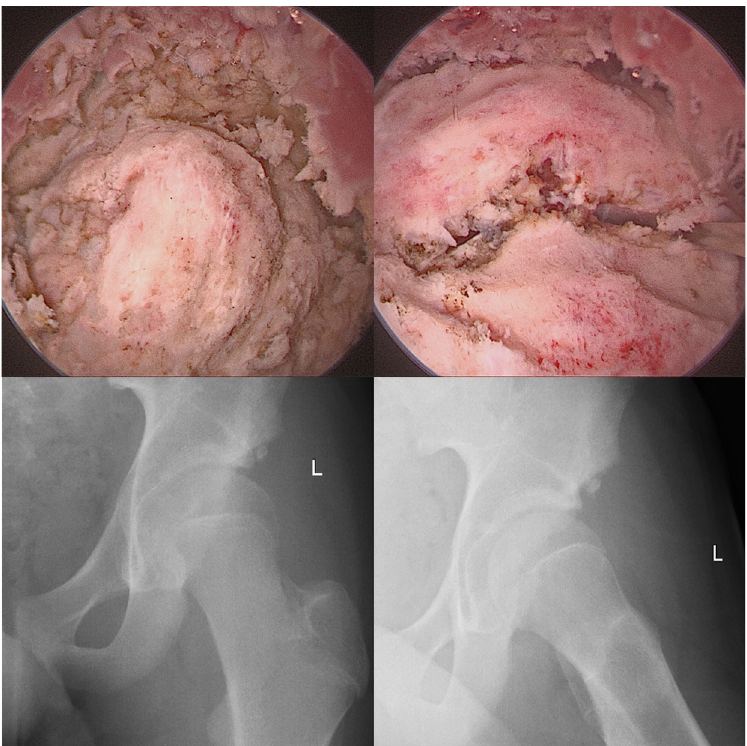
Figure 2. Arthroscopic images of the heterotopic ossi fi cation that occurred in the rectus femoris muscle which was excised and extracted via an incision made on the anterolateral aspect of the thigh, and post-operative radiograph which shows that the heterotopic ossi fi cation lesion was cleared